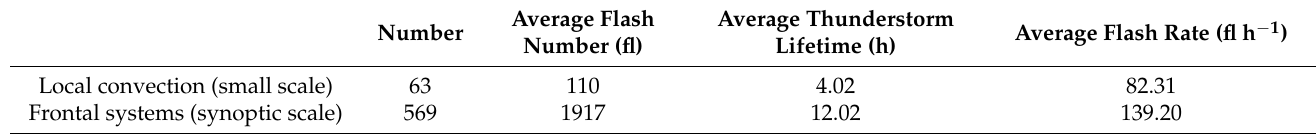
Table 1. Comparison of two types of